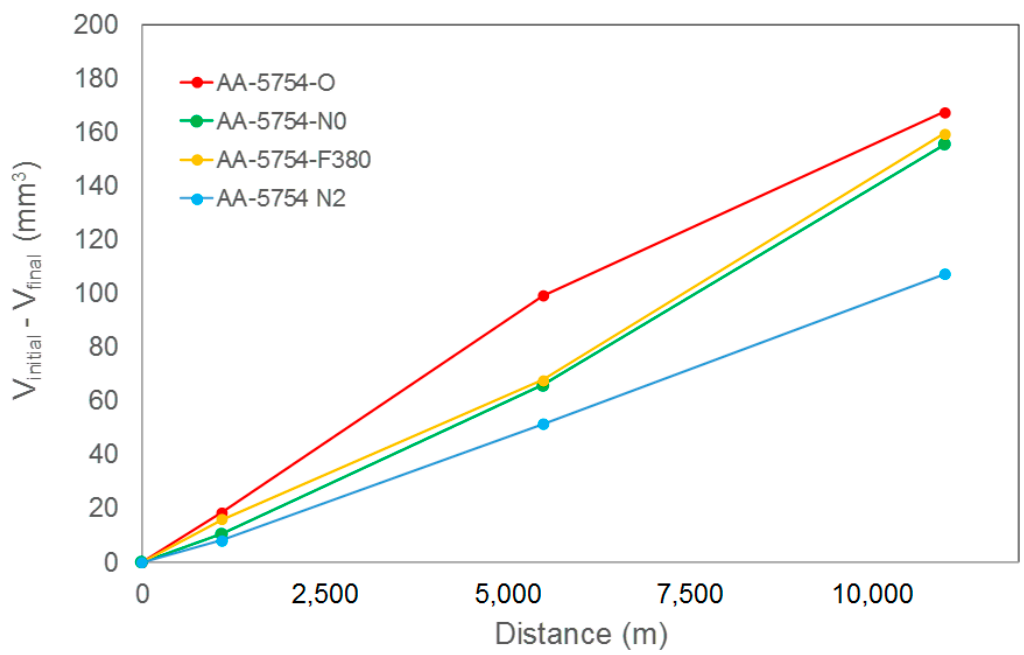
Figure 22. Wear vs. sliding distance for AA-5083. Metals 2020 , 10 , 938